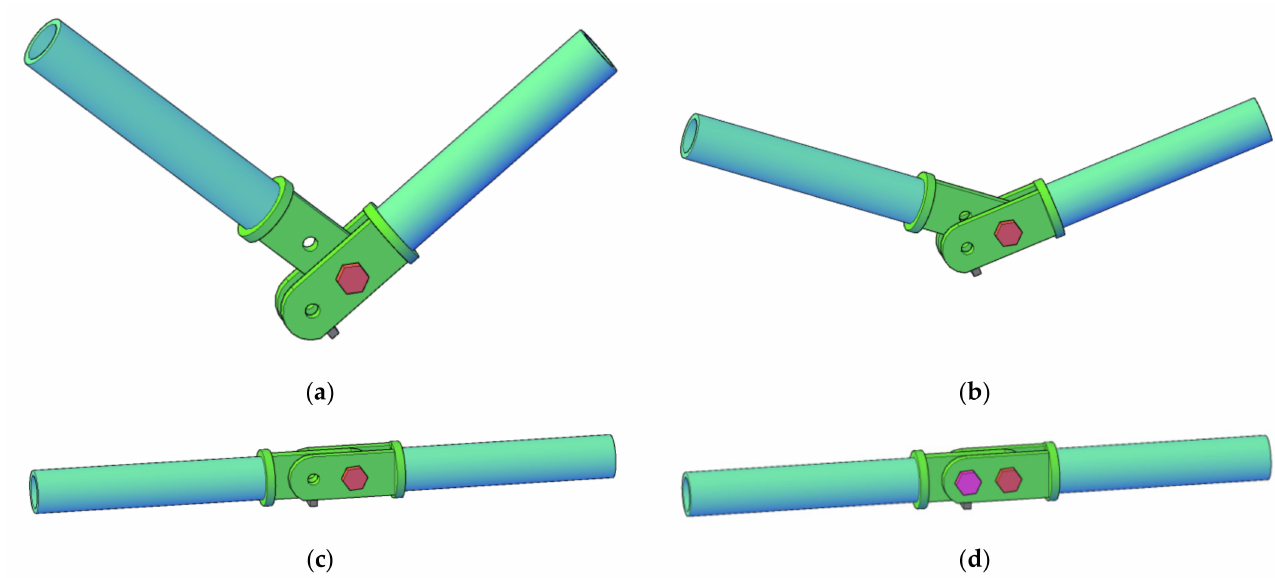
Figure 2. Flowchart of changing the mid-span connection of a ridge beam from hinged to rigid. ( a ) Connect the two segments with a screw bolt; ( b ) Start the integral tow-lifting construction with the free rotation of the two segments; ( c ) After the integral tow-lifting construction, the two segments behave in a straight line; ( d ) Install the other screw bolt to change the hinged joint to a rigid